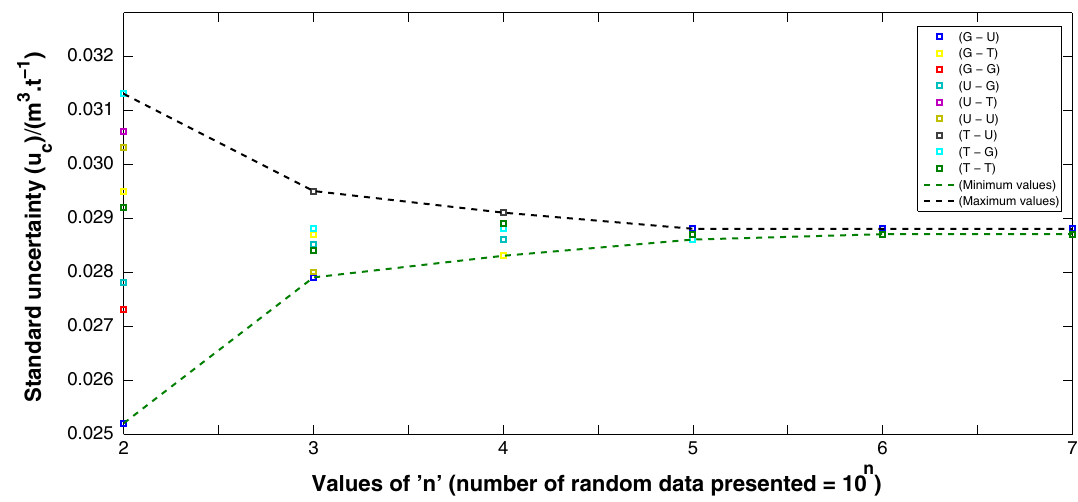
Fig. 2 Sensitivity analysis of the number of Monte Carlo trials for Gaussian ( G ), triangular ( T ) and uniform ( U )